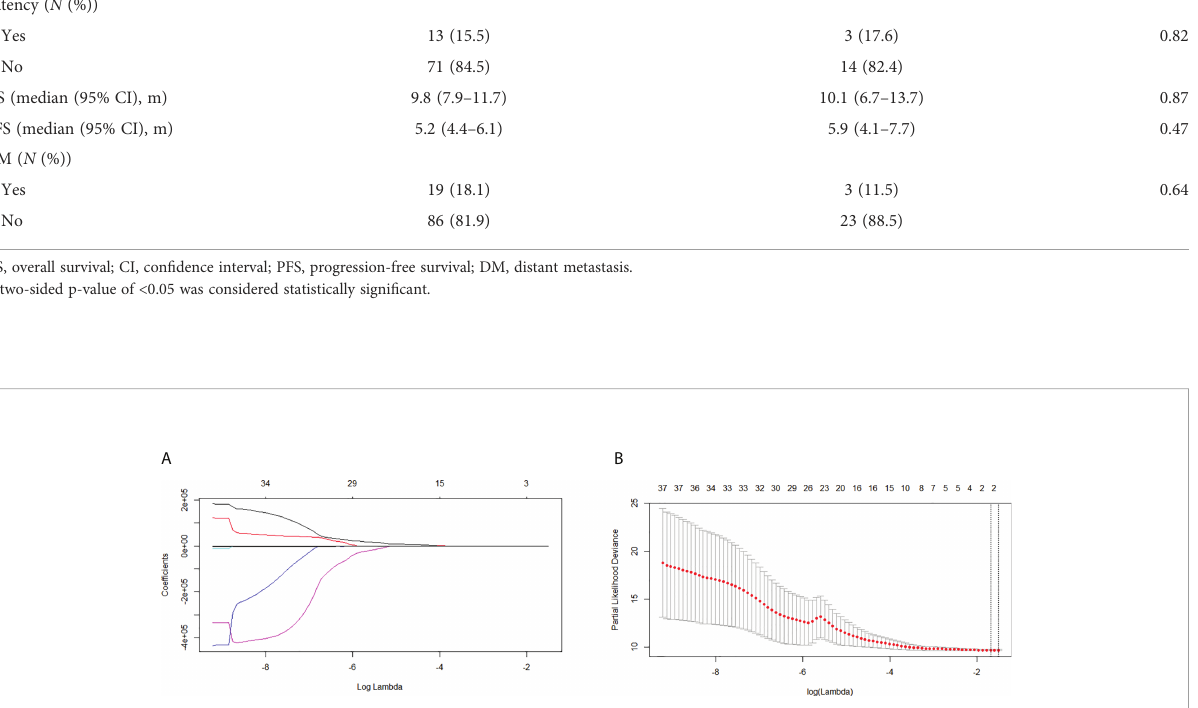
(Figure 6). The calibration curves of the radiomics-based nomogram and clinical nomogram are presented in Figure 7.